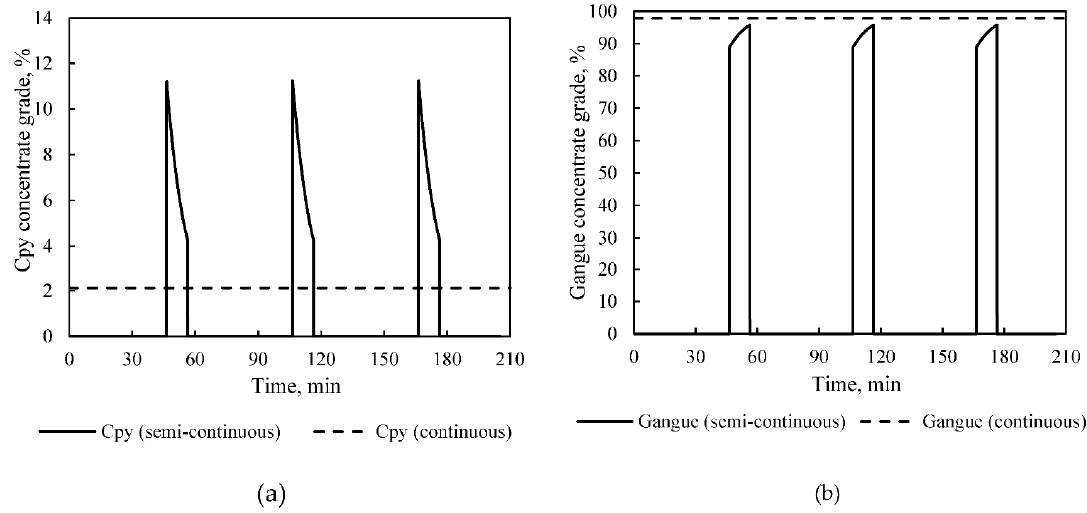
Figure 2. Semi ‐ continuous operation (simulated) versus continuous operation (experimental). Figure 2. Semi-continuous operation (simulated) versus continuous operation (experimental).